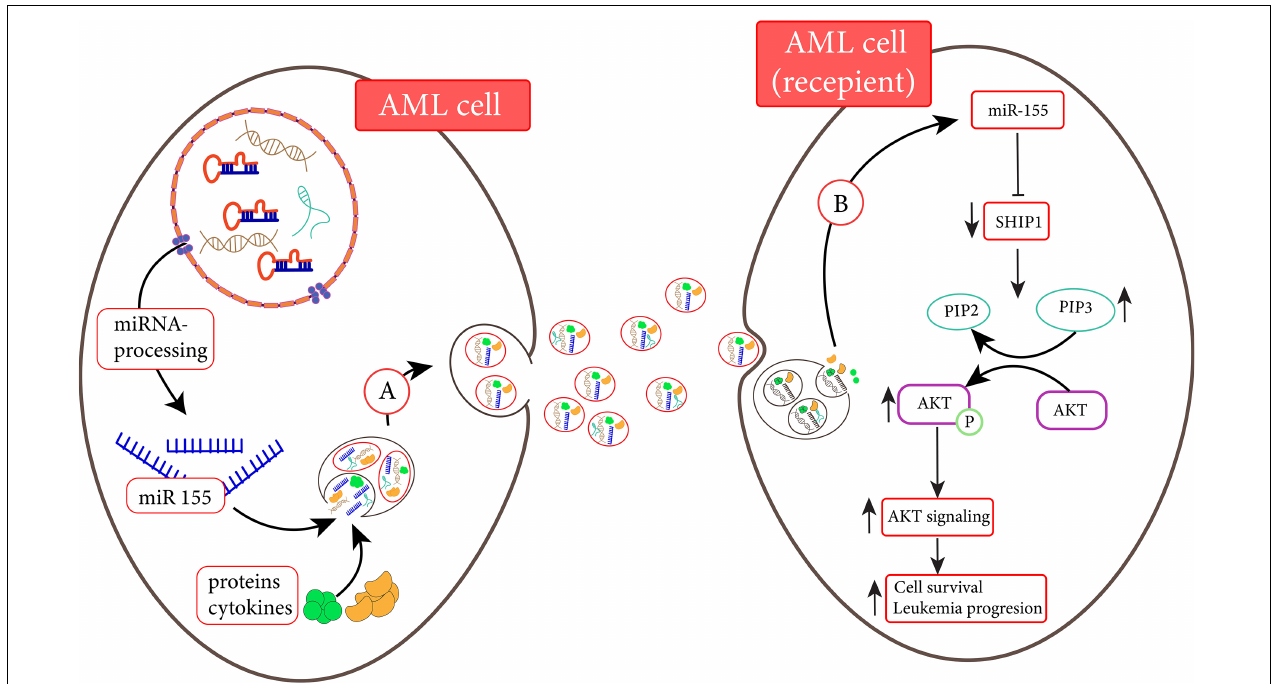
FIGURE 1 | AML cells are able to transfer miR-155 to another AML cell (Hornick et al., 2015). (A) MiR-155 and other elements are transferred to recipient cells via exosomes. (B) MiR-155 derived from exosomes is released into the recipient cell and inhibits the activated SH2 domain-containing inositol 5 (cid:48) -phosphatase1 (SHIP1) expression. Following the inhibition of SHIP1, the enhancement of AKT signaling promotes cell survival (Xue et al.,